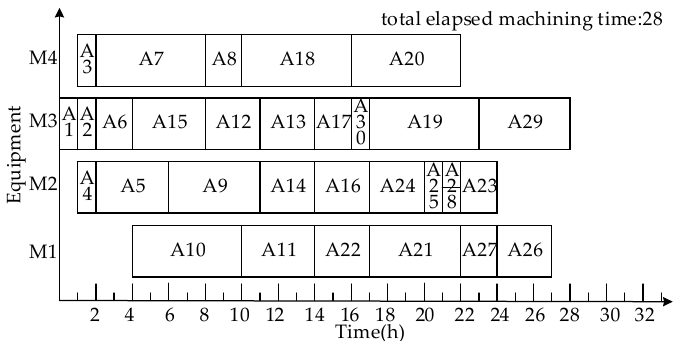
Figure 5. Gantt chart of P 62 .